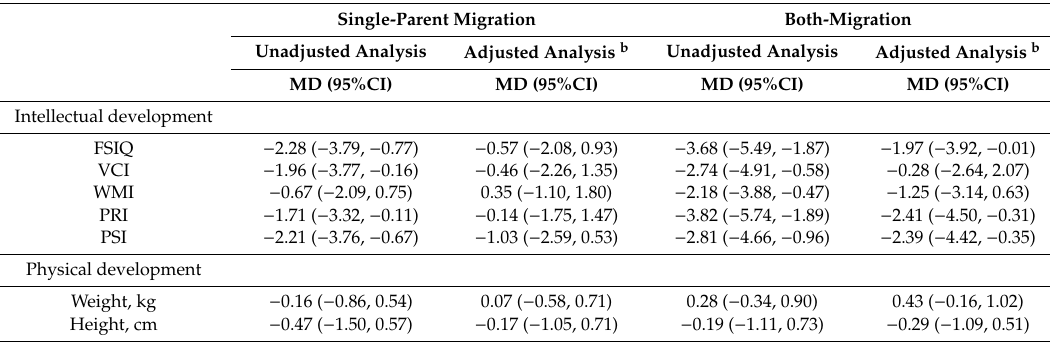
Table 3. Comparison of WISC-IV Test Scores by parental migration status a